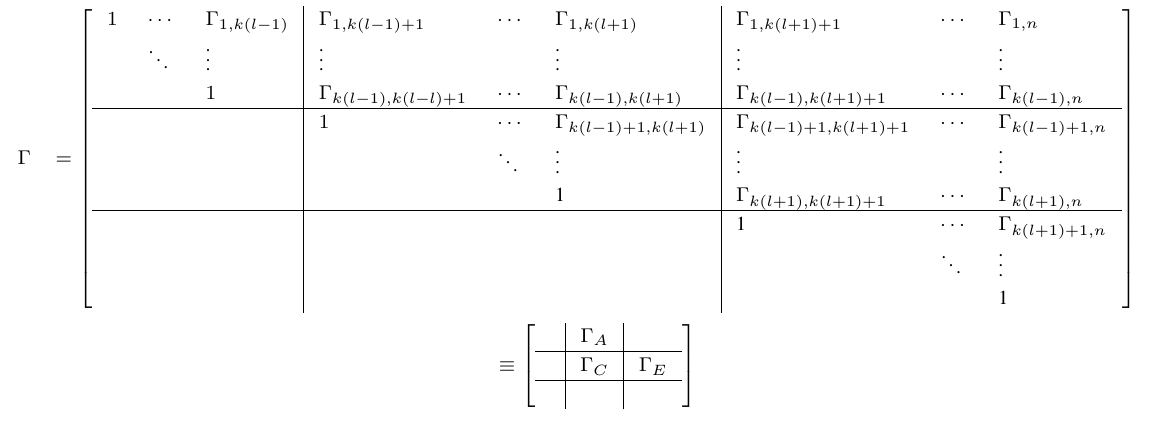
Figure 11. The Local LLL